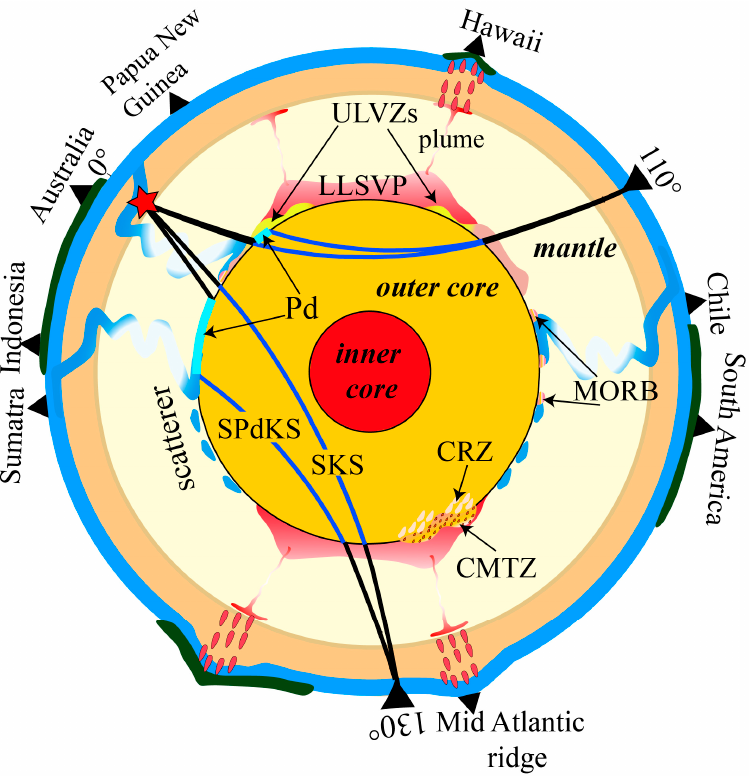
Figure 1. Schematic illustration of lowermost mantle structures and their sampling due to SKS and SPdKS waveforms. SKS and SPdKS ray paths are drawn with source-side P-diffraction (cyan color lines) at the CMB at 110° and 130° epicentral distances.